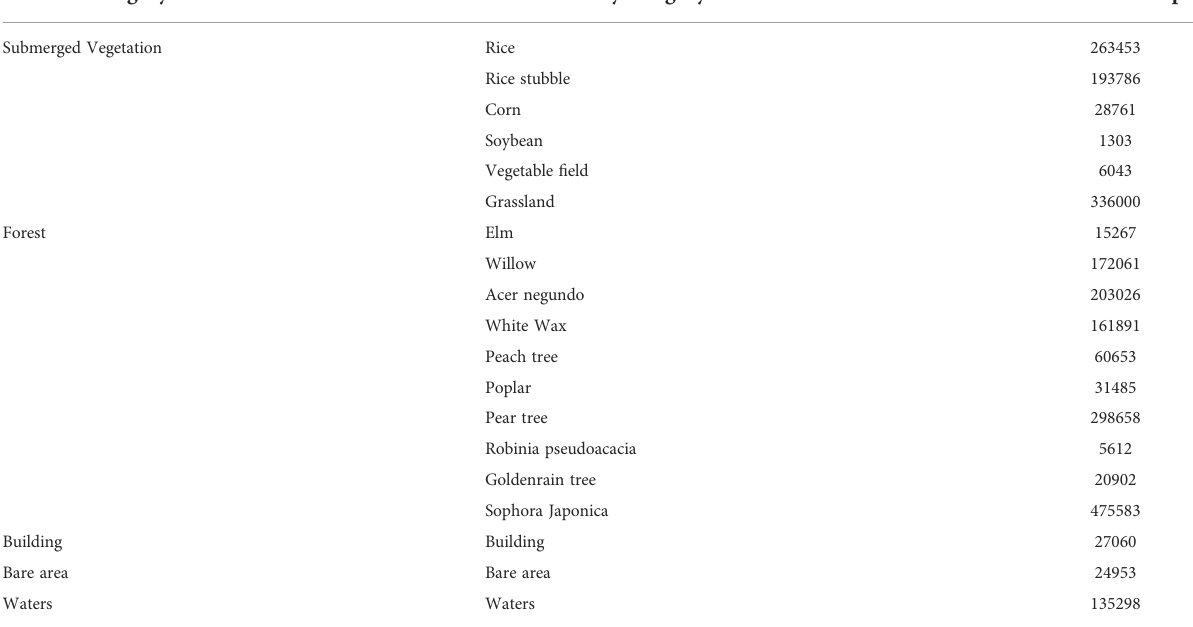
TABLE 1 Vegetation classi fi cation system of Matiwan